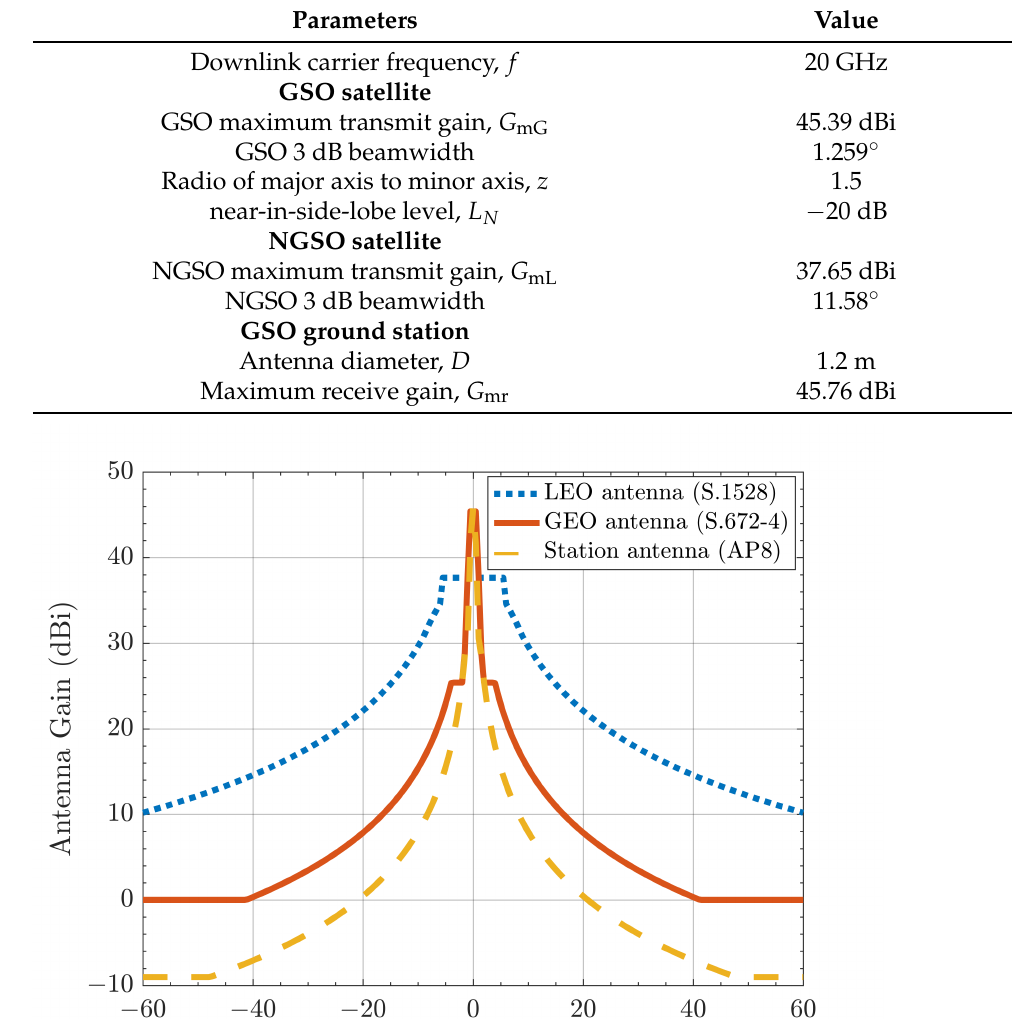
Table 1. Simulation parameters of antenna gains.